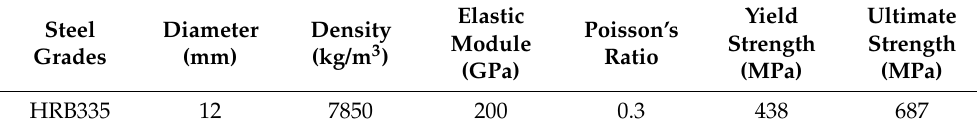
Table 2. Parameter of steel model